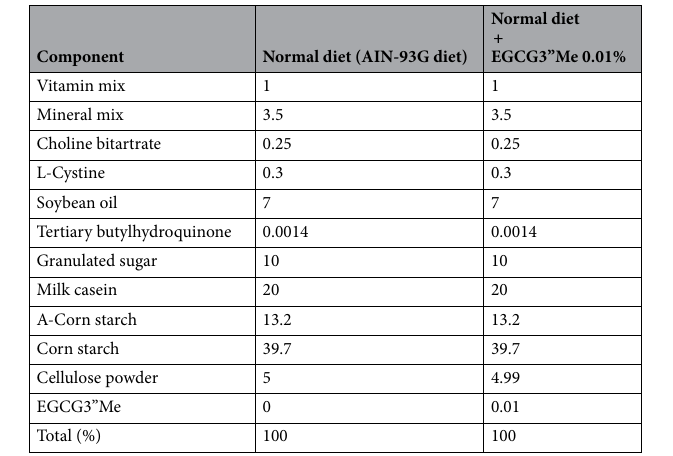
Table 1. Normal diet and EGCG3”Me 0.01% containing